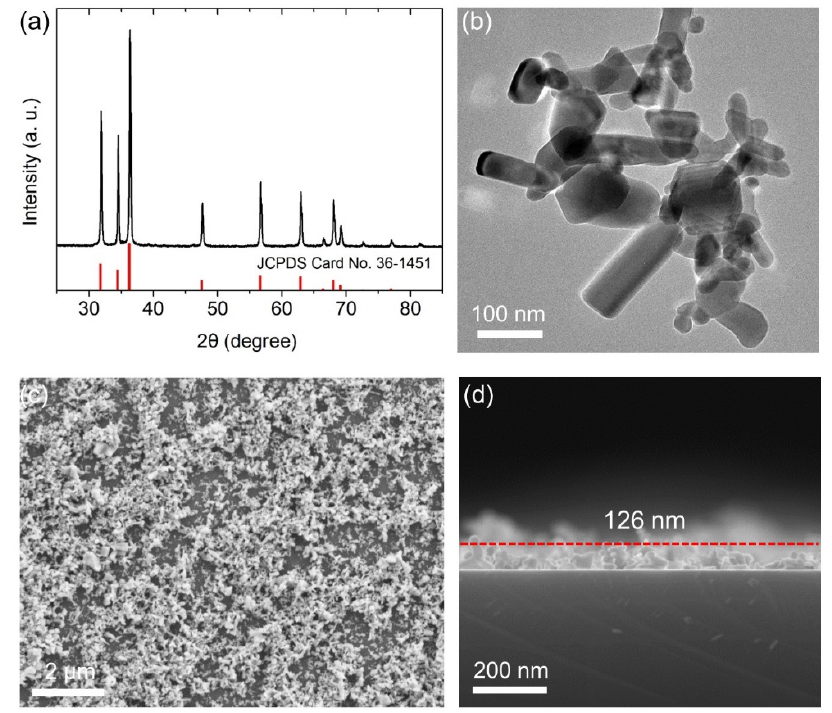
Figure 4. ( a ) XRD pattern of ZnO nanocrystals; ( b ) TEM image of ZnO nanocrystals; ( c ) SEM surface image of ZnO nanofilm; ( d ) cross section SEM image of ZnO nanofilm.